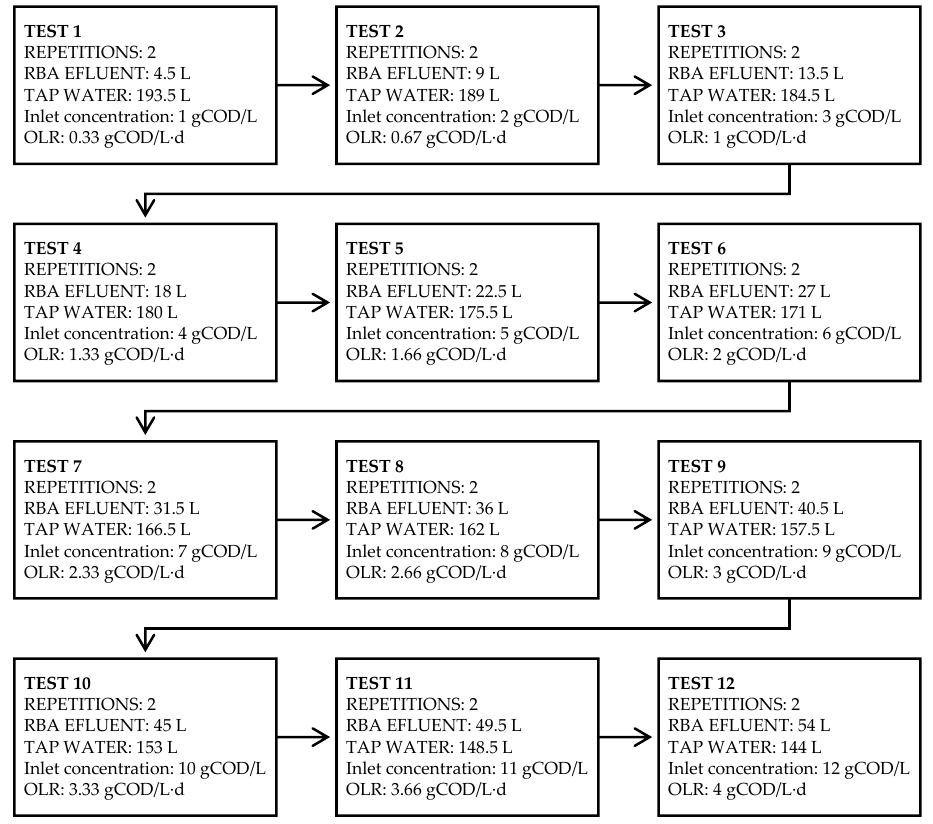
6 of 17 Figure 2. Monocultures and polycultures in the constructed wetland system. •